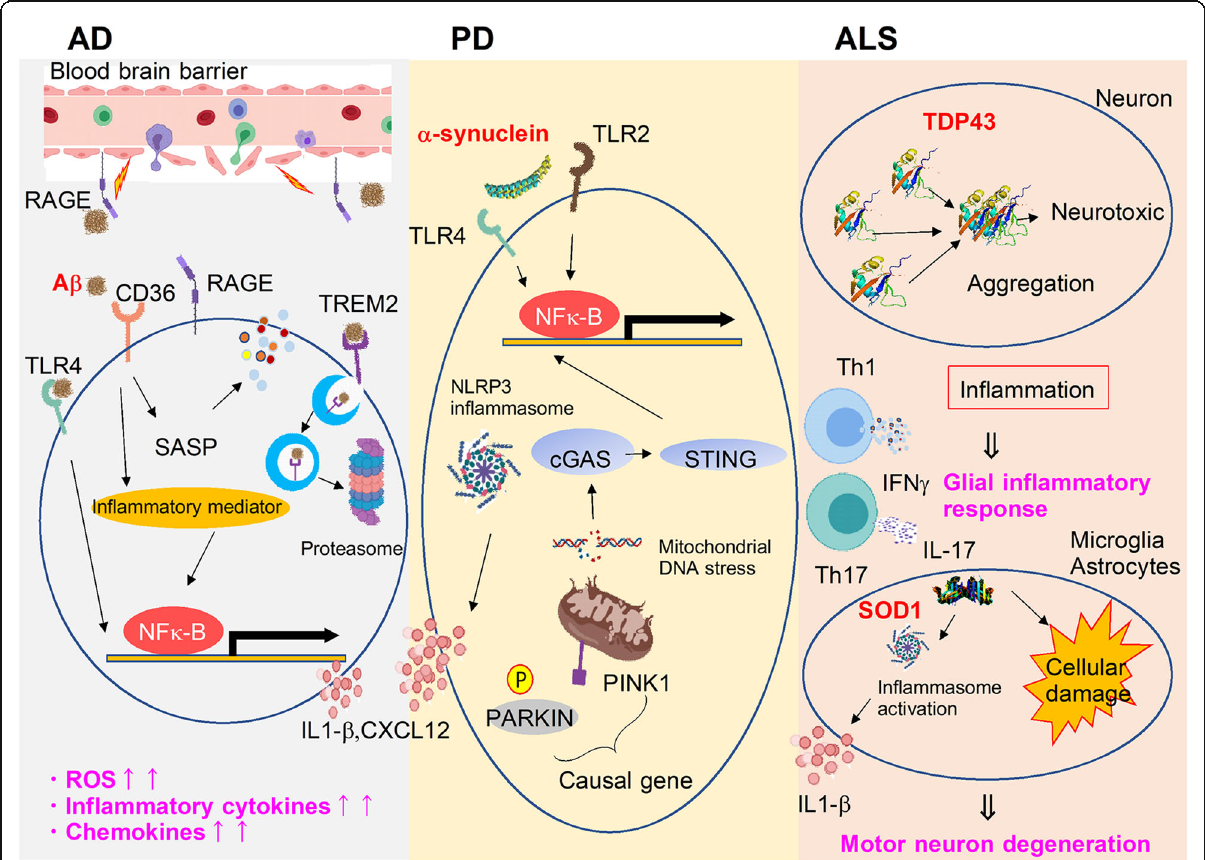
Fig. 2 Different mechanisms of neuroinflammation among AD, PD, and ALS. This is the summarized figure of molecular and cellular mechanisms of sterile neuroinflammation in AD, PD, and ALS. Different cells and molecules regulate the neuroinflammation that has a pivotal role in the induction of each CNS